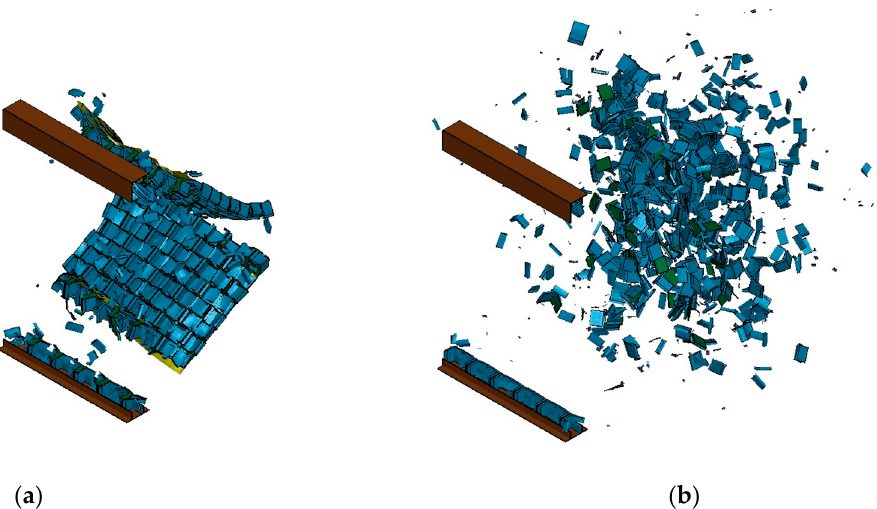
Figure 9. Comparison of damage pattern in Test 2: ( a ) 3.175 mm SPUA-retrofitted; ( b ) No retrofit- ting.